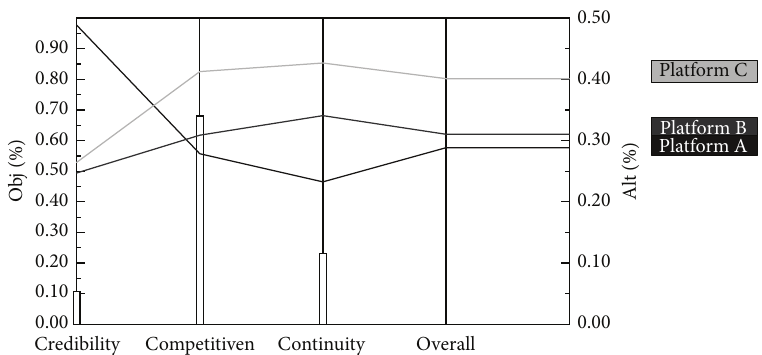
Figure 3: Sensitivity analysis (exported from Expert Choice).